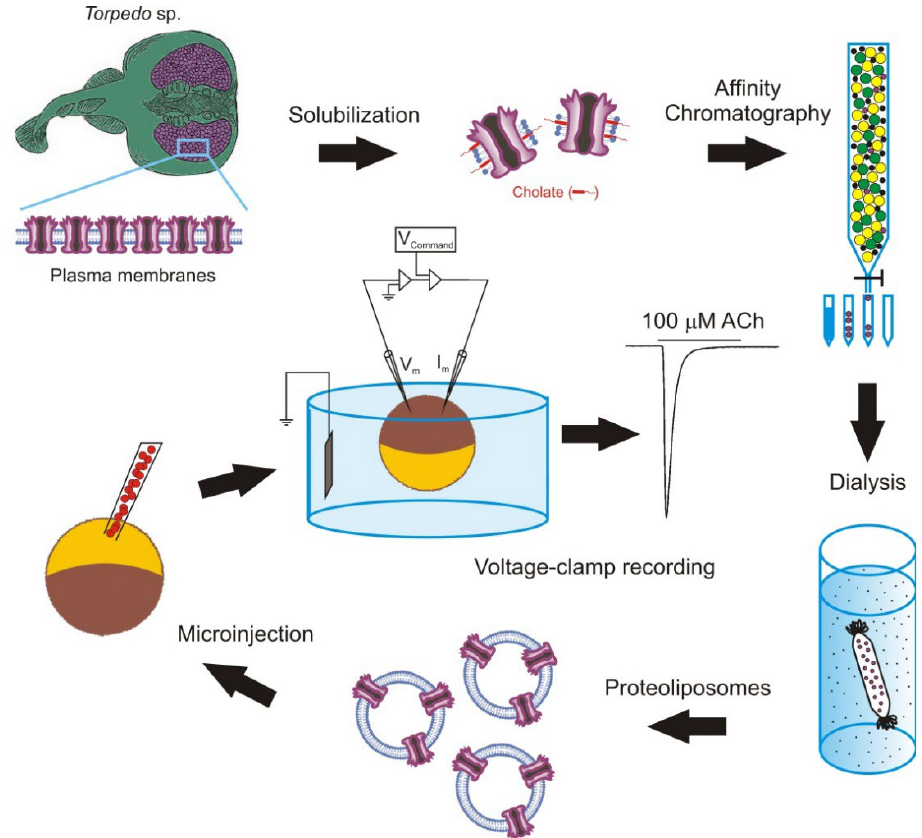
Figure 2. Methodology followed to microtransplant foreign membrane proteins to oocytes. Scheme of the steps to microtransplant the purified and reconstituted nicotinic acetylcholine (ACh) receptors (nAChRs) to the Xenopus oocyte membrane to carry out detailed functional studies.